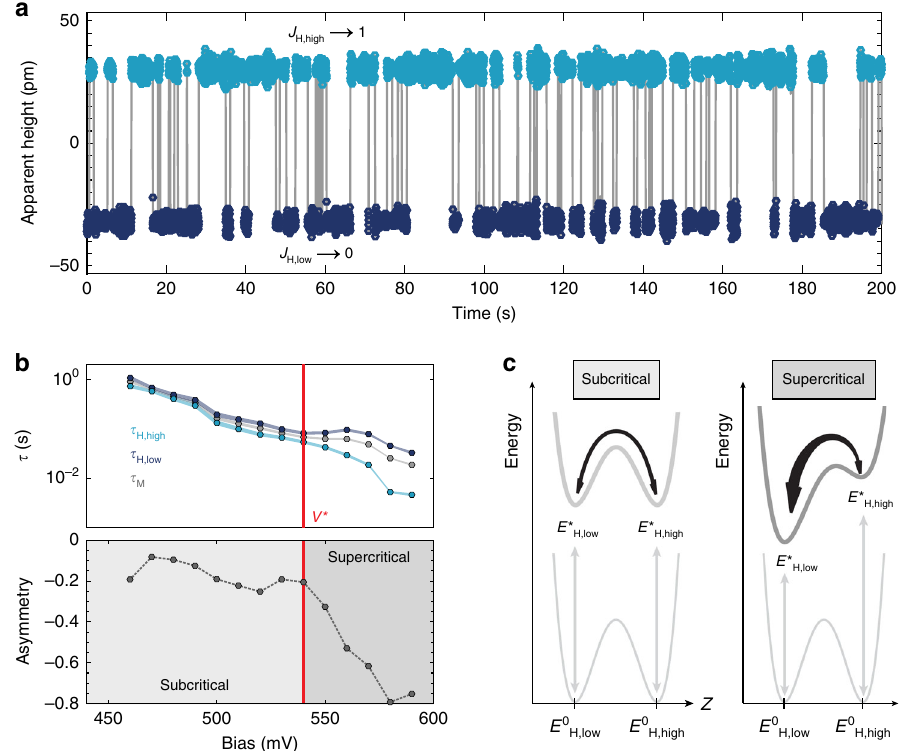
Fig. 4 Orbital memory. a Two-state conductance signal with J H,high (light blue) showing high conductance and J H,low (dark blue) showing low conductance. b State lifetime and asymmetry as a function of tip bias with tip height held constant. Linewidth of lifetime curves indicates measurement error. V* highlights critical threshold where TIBB causes lifetime depression for J H,high . c Energy schematics illustrating excitation/ionization ( E 0 to E *) and switching mechanism for orbital memory. (Left) Sub-threshold behavior with nearly equivalent lifetimes (symmetric upper well structure) and (right) supercritical behavior with strongly diminished J H,high lifetime (imbalanced upper well